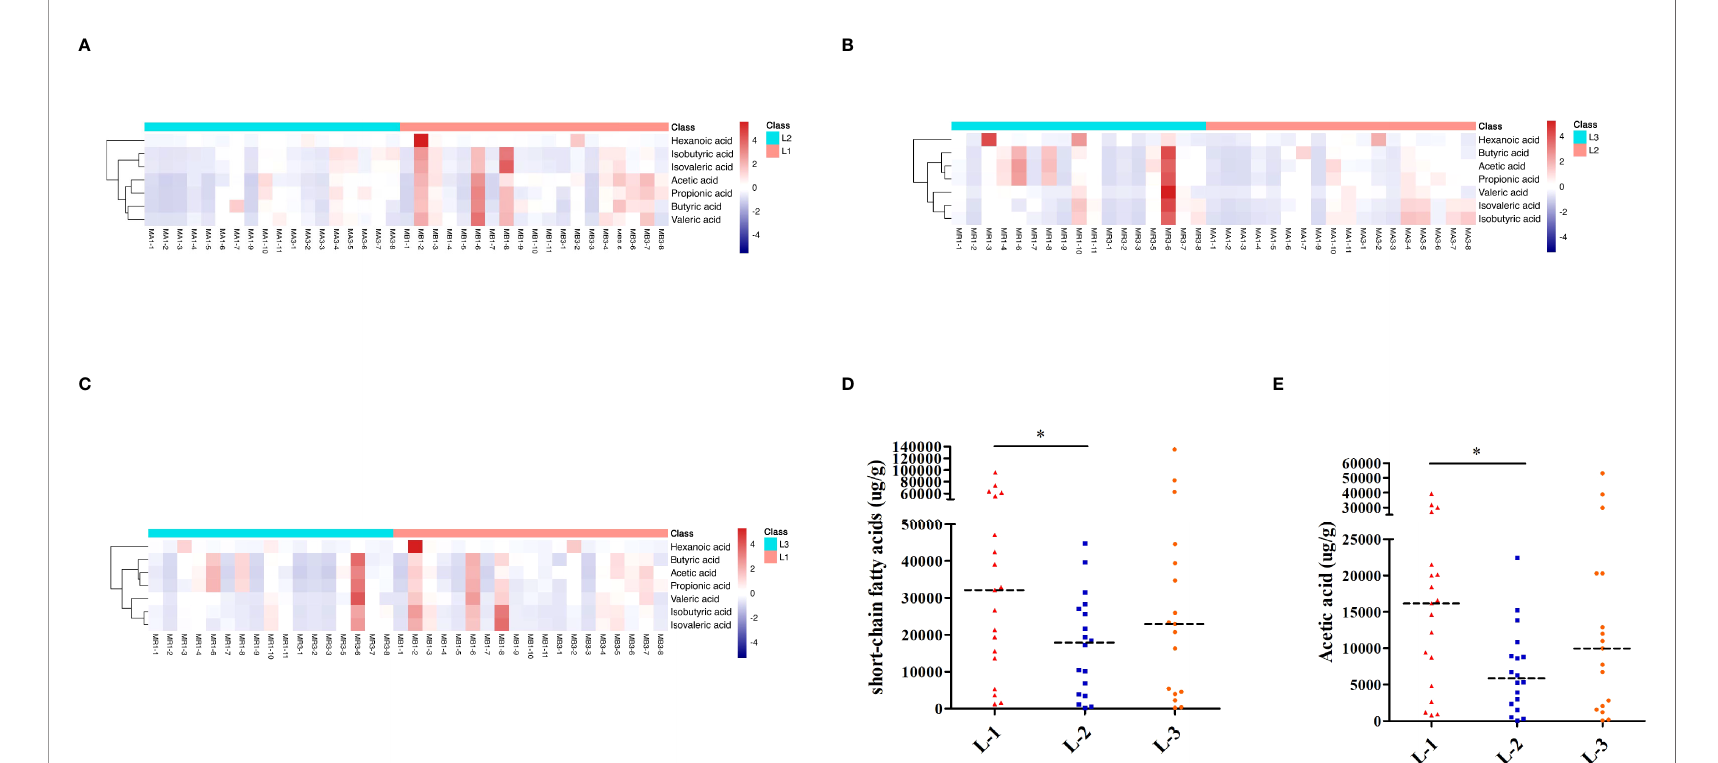
FIGURE 6 | SCFA analysis of L-VA therapy. Heatmap of SCFA differences across different samples at the three time points of L-VA therapy ( A for L-1 and L-2, B for L-2 and L-3, C for L-1 and L-3). The quanti fi cation of total SCFAs (D) and acetic acid (E) at the three time points of L-VA therapy. Red represents a positive association, and blue represents a negative association. L-1: the time point before eradication in the L-VA group; L-2: the time point after eradication in the L-VA group; L-3: the time point of con fi rmation in the L-VA group; * P